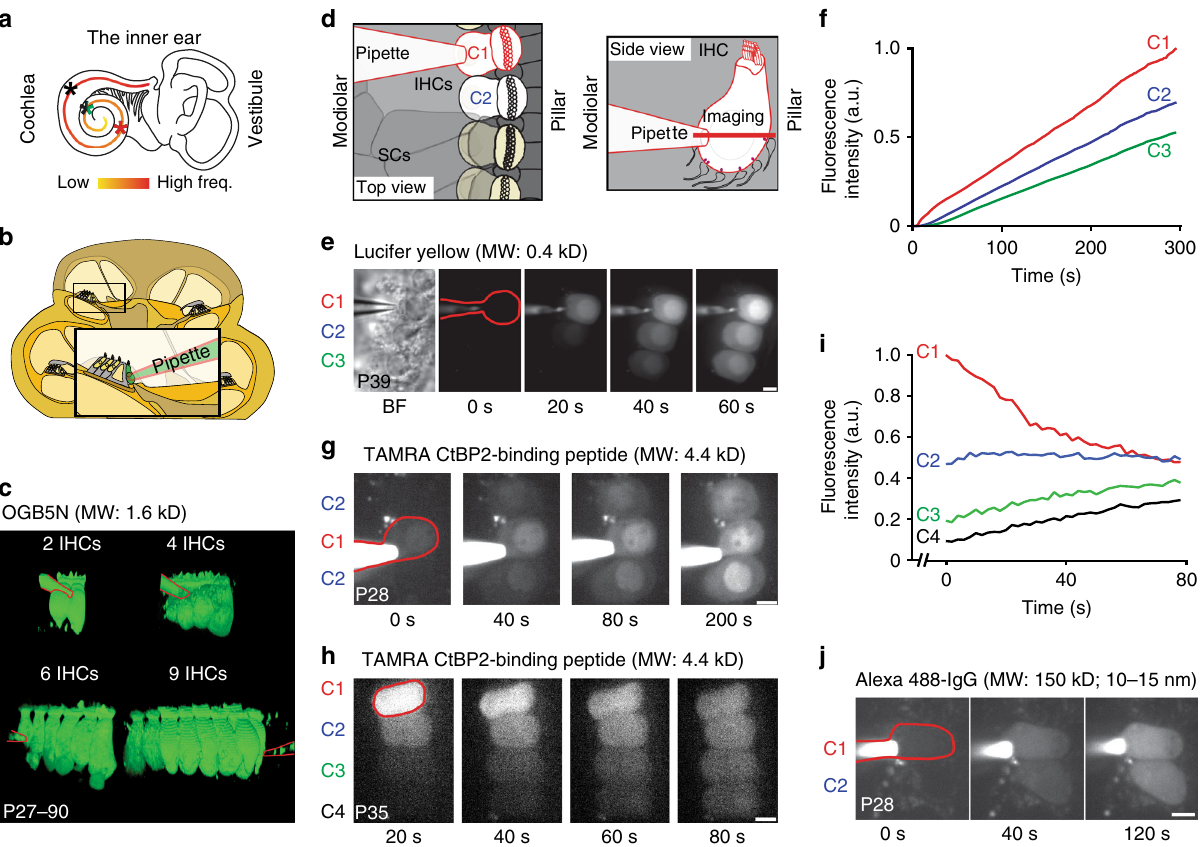
Fig. 1 Macromolecular coupling between mature mouse IHCs. a Illustration of the cochlea with the tonotopic map color-coded for frequency and approximate positions of patching indicated with asterisks (red = mouse temporal bone preparation; green = mouse excised organ of Corti; black = gerbil excised organ of Corti (Supplementary Fig. 2)). b Drawing illustrating the temporal bone preparation, where the bone covering the apical turn is removed. c 3D view of OGB5N fl uorescence in 2,4,6, and 9 coupled IHCs, with pipette delineated in red. d Drawings illustrating the excised organ of Corti with SCs removed to allow patching of one IHC (C1, outlined in red in e , g , h , and j ), loaded IHCs in white (C1, C2), imaging plane as red bar. e Time series of Lucifer Yellow loading into 3 coupled IHCs, shown in bright fi eld (BF) on the left. f Normalized fl uorescence intensities over time from e . g Time series of TAMRA loading into 3 coupled IHCs. h TAMRA-peptide diffusion between 4 coupled IHCs after retracting the patch-pipette from C1. i Normalized fl uorescence intensities over time from h . j Time series of Alexa 488-IgG loading in 2 coupled IHCs. a.u. arbitrary units, IHC inner hair cell, MW molecular weight, P postnatal day, SC supporting cell. Scale bar = 5 µ m in e – j